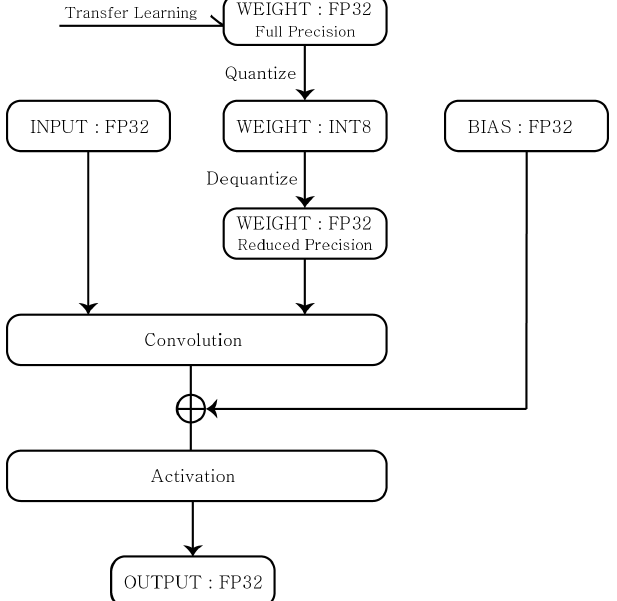
Figure 3. Baseline Quantization.